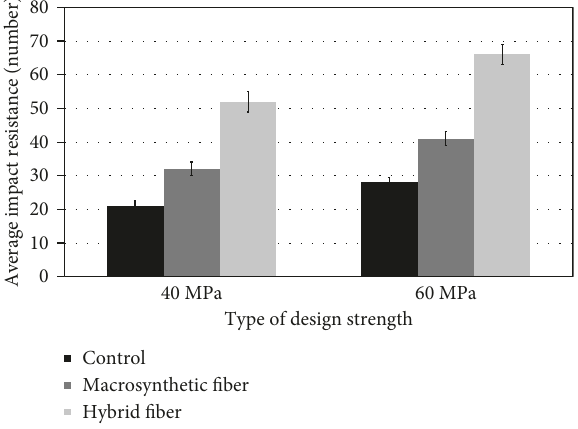
Figure 19: Impact resistance of optimum mix ratio.